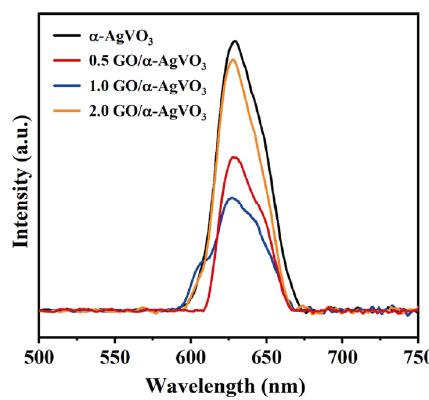
Fig. 12 PL spectra of pure α -AgVO 3 nanorods and GO/ α -AgVO 3 nanocomposites with different amount of GO.